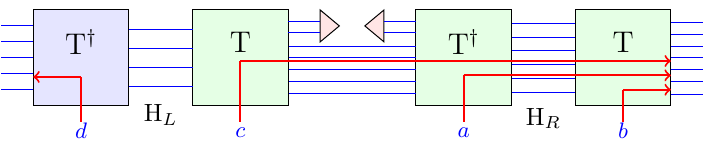
Figure 13 . Tensor network representation of the partially entangled thermal